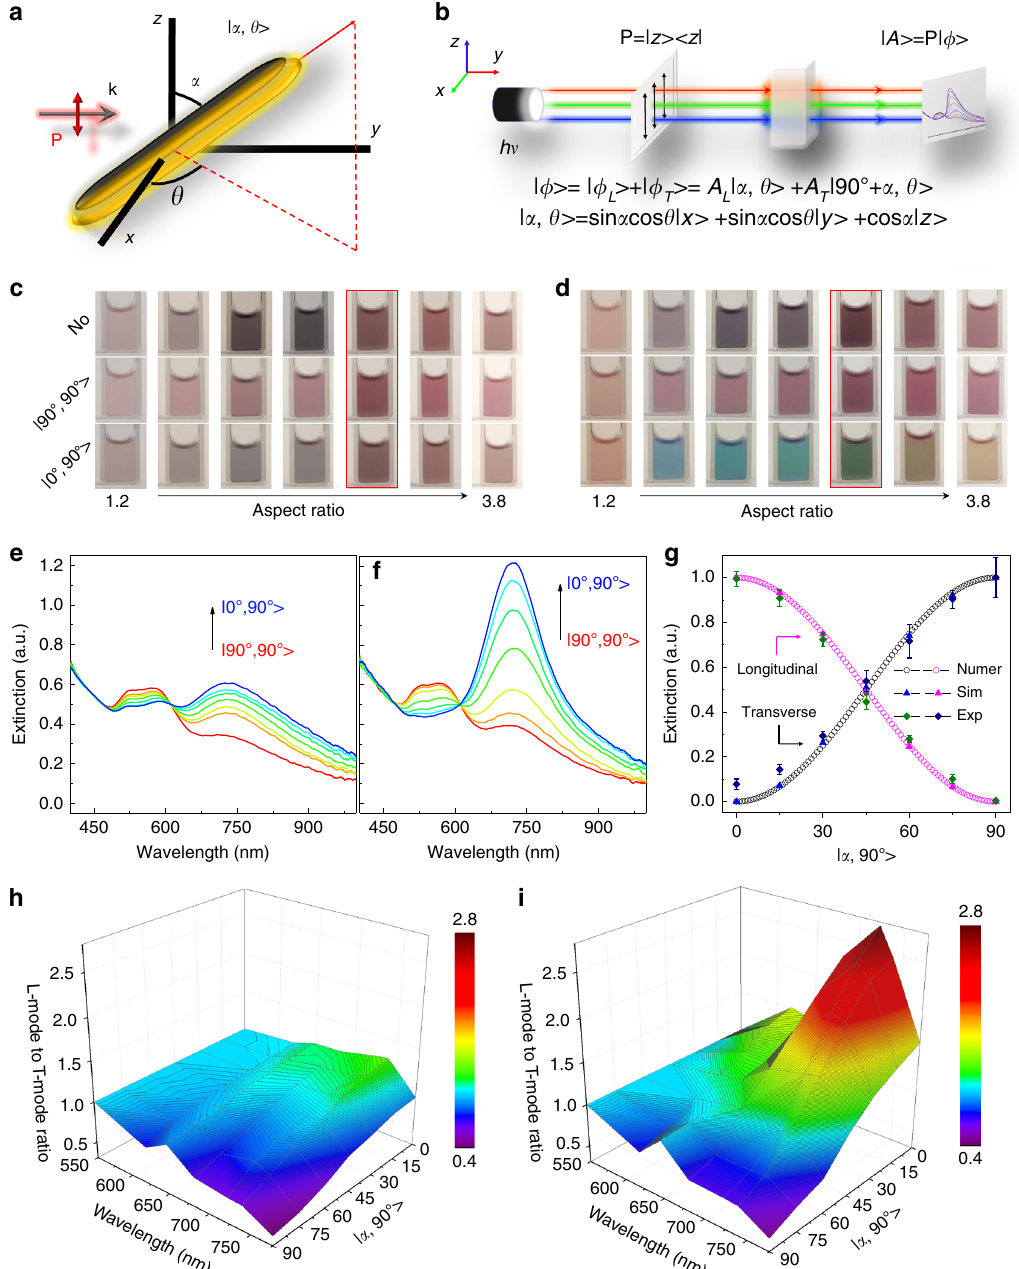
Fig. 2 Optical tunability of colloidal cAuNRs. a Schematic illustration of cAuNRs under the orientational state | α , Ɵ > with respect to the polarization of light. b Tuning plasmonic extinction of cAuNRs under polarized light and the corresponding mathematical interpretation by bra-ket notation. c , d Digital images of cAuNRs dispersions under normal ( c ) and polarized light ( d ). In both c and d , the colloidal dispersions from left to right correspond to spectra in Supplementary Fig. 2f (from bottom to top). e , f Tuning the extinction of cAuNRs under normal ( e ) and polarized light ( f ) for samples of highlighted columns in ( c ) and ( d ), respectively. e , f share the same y axis. The spectra were measured with an angle step of 15 o . g Correlation between the excitation modes and orientational states of cAuNRs, with the fi ne spectra tunability shown in f . The abbreviations, Numer, Sim, and Exp, represent numerical, simulation, and experimental results, respectively. Error bars represent the standard deviations from three experimental measurements. h , i Summary of L- mode to T-mode ratio of different dispersions in c and d achieved by varying α under normal ( h ) and polarized light ( i ). The azimuth angle, Ɵ , was set at 90 o . P and k are the polarization and wave vector of the incident light, transverse extinction (E T ) as f( α ) = E L ( α )/E T ( α ). As summarized solutions once aligning the cAuNRs from y axis to z axis via a in Fig. 2h, the highest contrast under ordinary light is 1.25, which magnetic fi eld (Fig. 2c). is of high consistency with the gray/brown color in the aqueous solutions (bottom panel in Fig. 2c). Under polarized light, the factor can be modulated in a much broader range, from 0.5 to 2.7 (Fig. 2i), giving rise to obvious color changes in the aqueous